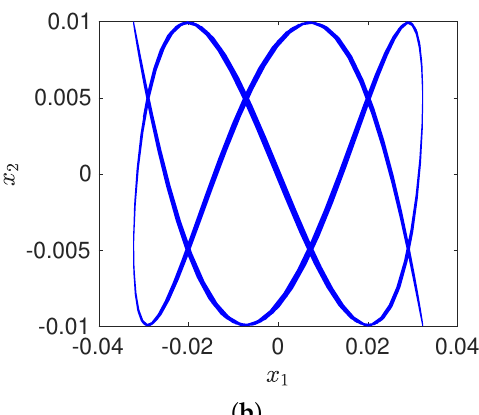
Figure 5. ( a , b ) Phase portraits of the charged dilaton black hole system for different λ 1 / λ 2 with (cid:101) =